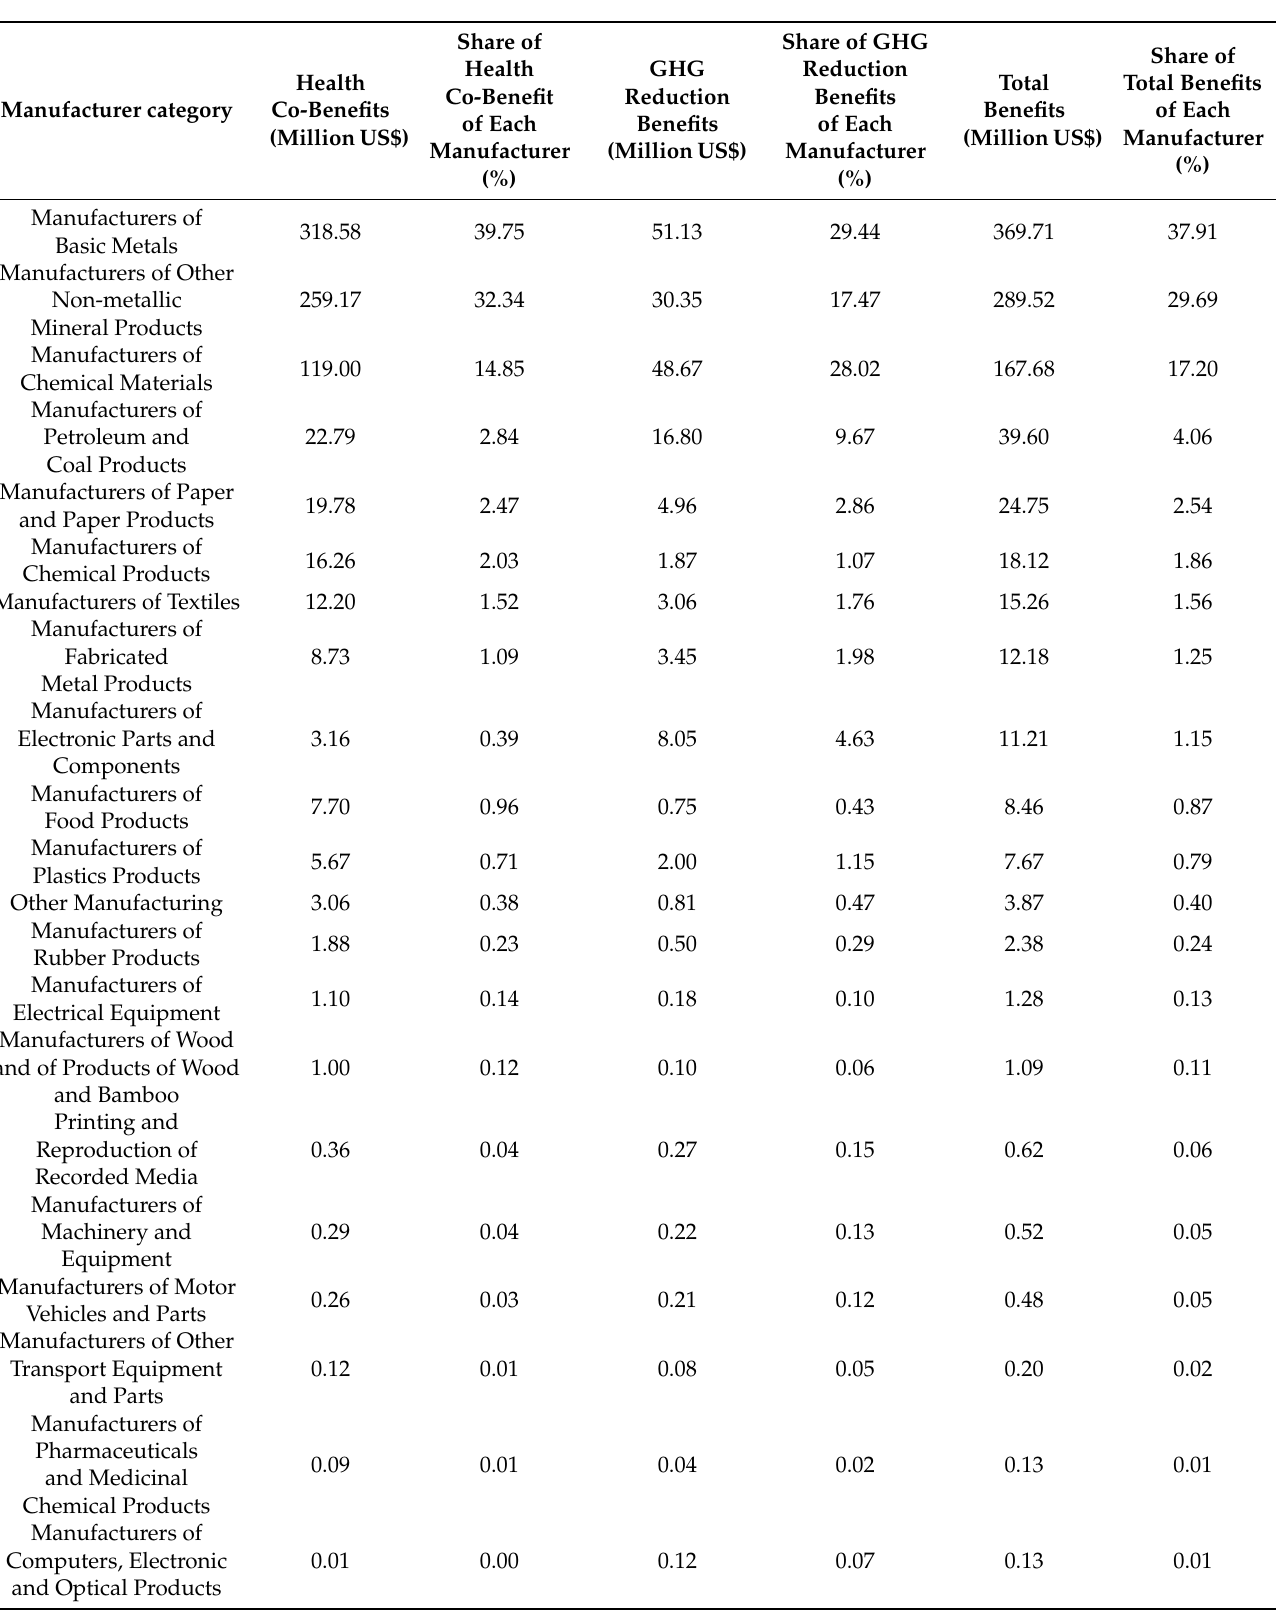
Table 6. Health co-benefits and GHG reduction benefits for the 25 manufacturers simulated in scenario